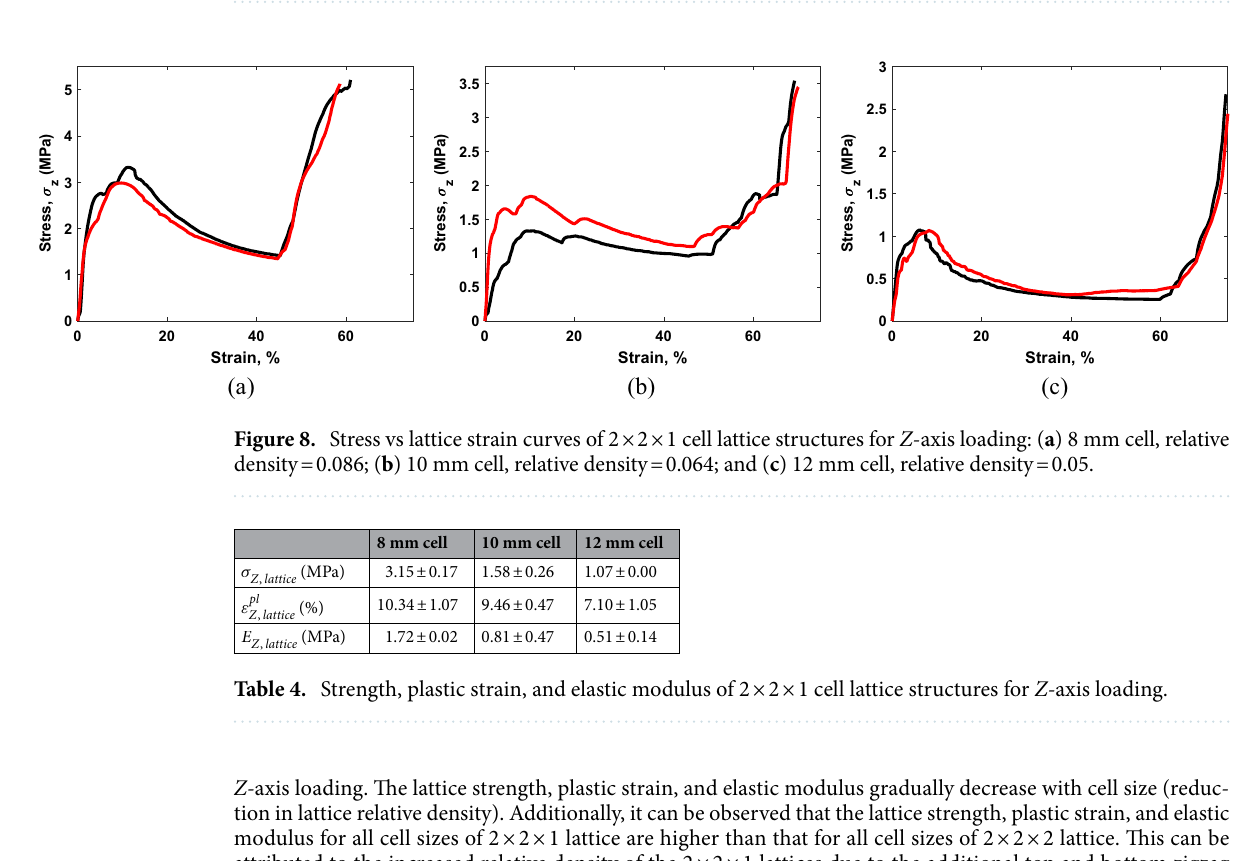
Table 3. Strength, plastic strain, and elastic modulus of 2 × 2 × 2 cell lattice structures for Z- axis loading.